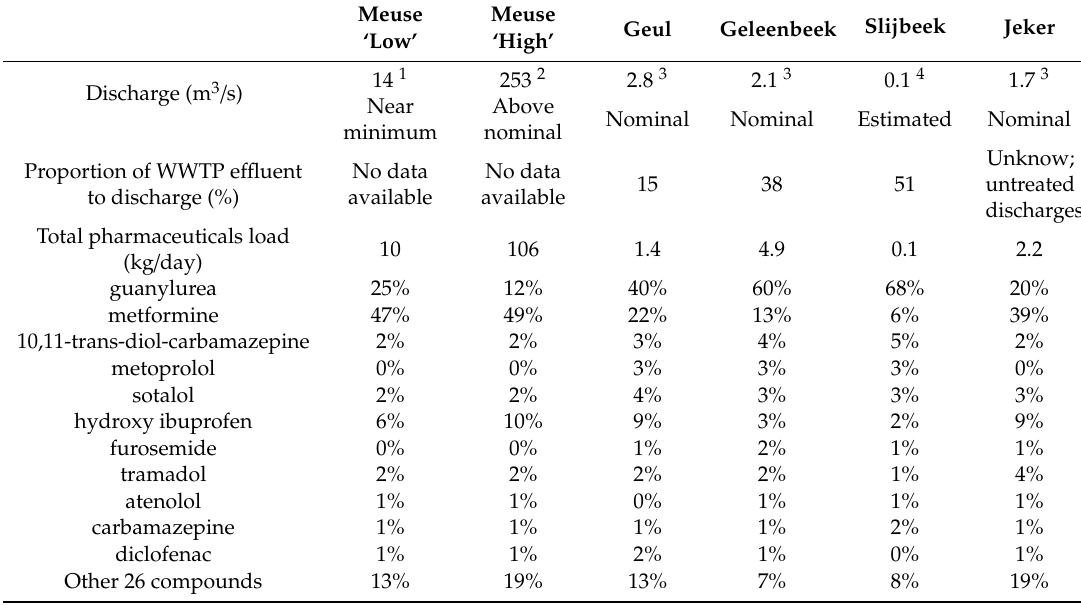
Table 1. Most common pharmaceuticals and metabolites detected in the River Meuse and its tributaries in The Netherlands, expressed as the average contribution (%) to the total load of pharmaceuticals and transformation products